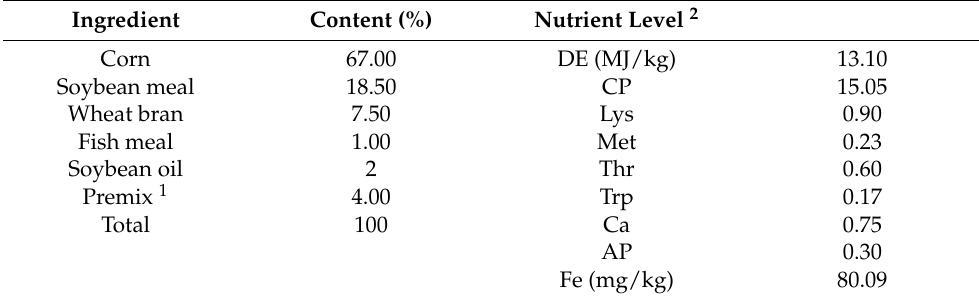
Table 1. Composition and nutrient levels of basal diet (air-dry basic).